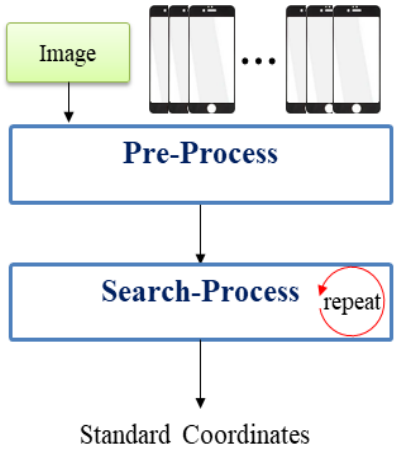
Figure 4. Process of extracting the reference point of the product.